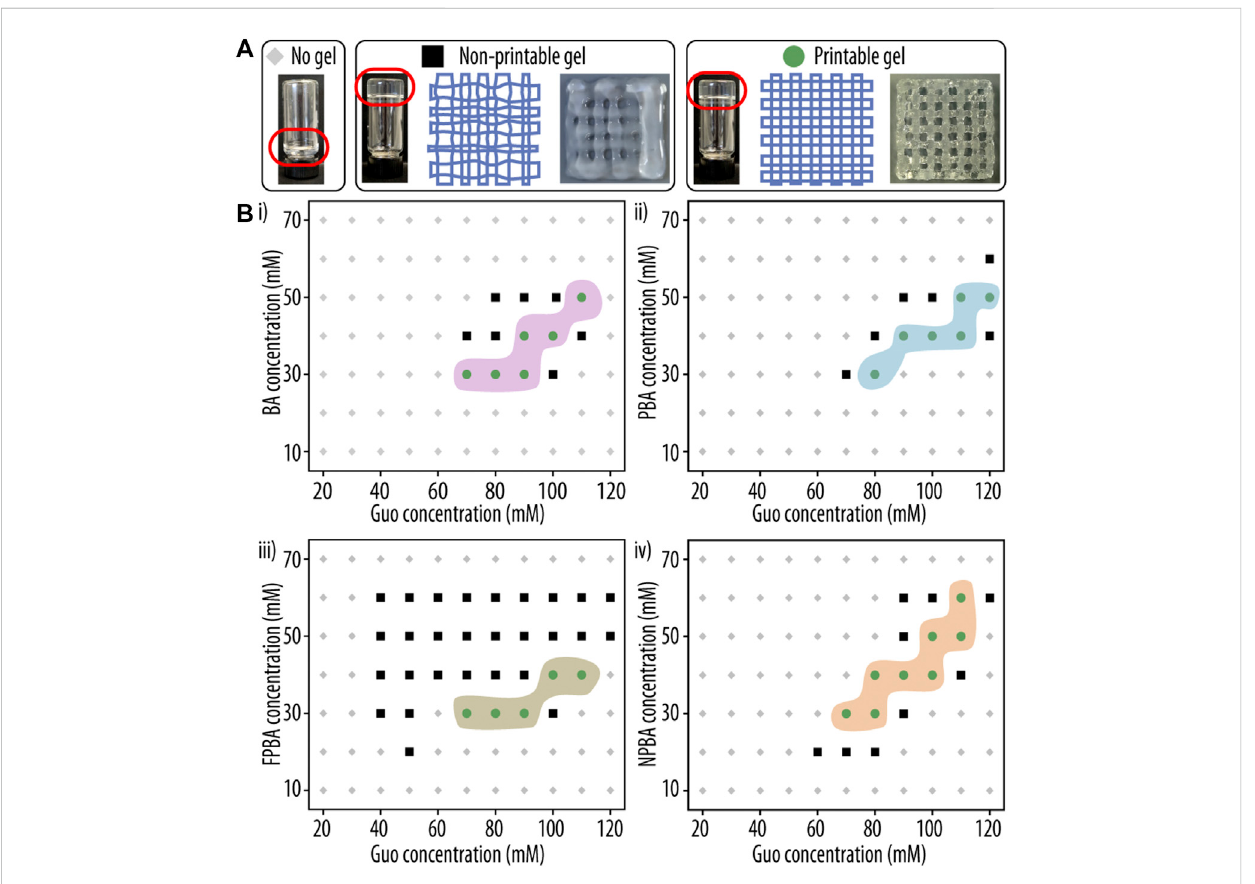
FIGURE 3 Printability assessment of guanosine (Guo)-based hydrogels with boric acid derivatives (GB hydrogels). (A) Representative images of hydrogel formulationsyieldingeithernogel(left),anon-printablegel(middle),oraprintablehydrogel (right)areshown. (B) PhasediagramofGBhydrogelgelation after1 hatroomtemperature(RT)asafunctionsofGuoconcentrationand(i)boricacid(BA),(ii)phenylboronicacid(PBA),(iii)2-formilphenylboronicacid (FPBA) and (iv) 2-naphtylboronic acid (NPBA) concentration. Compositions resulting in three-dimensional (3D)-printable hydrogels are indicated as green circles, non-printable solutions as black